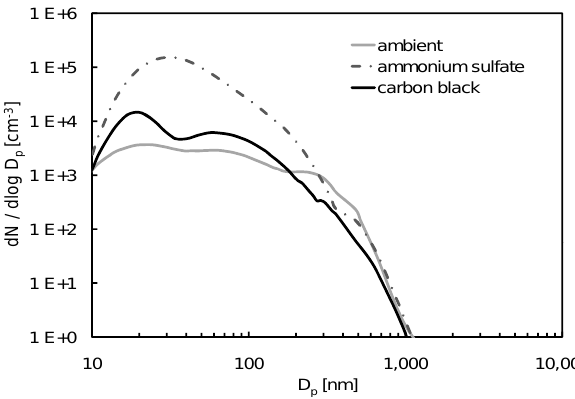
Fig. 3. Particle number size distributions for two sizes for am- monium sulfate, for carbon black, and for ambient air during EUSAAR2007. The number distributions for ammonium sulfate and carbon black are composites of number distributions measured with the SMPS and the APS. For ambient air APS measurements were not